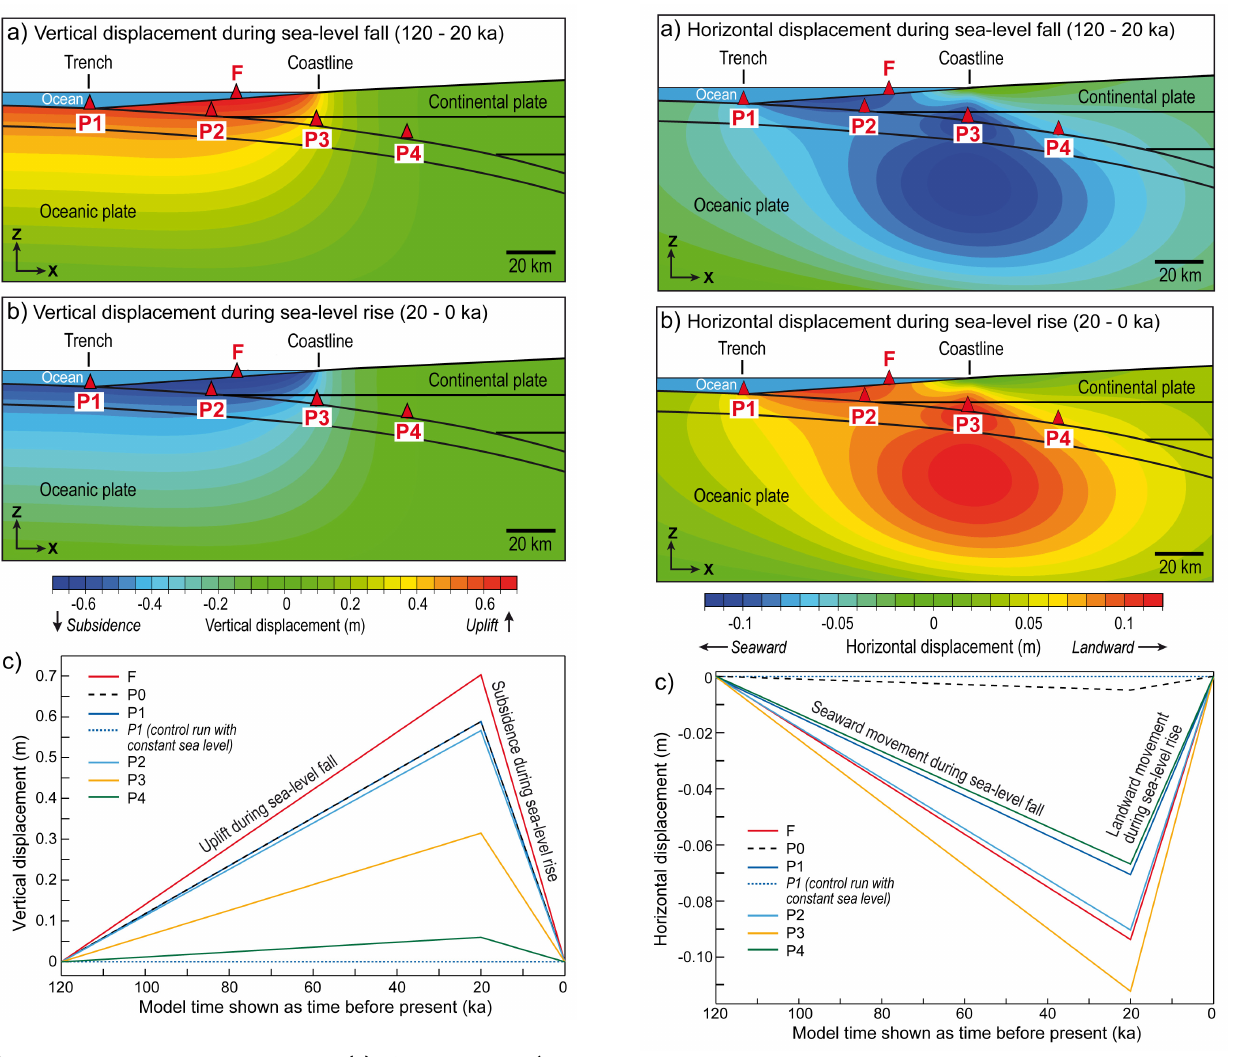
Fig. 3. Horizontal displacement induced by (a) a falling sea level (120–20ka) and (b) a rising sea level (20–0ka). (c) Temporal evo- lution of the horizontal displacements at point F in the forearc and at points P0–P4 located on the plate interface (Figs. 1a, 3a). For ref- erence, the result from the control run (constant sea level) is shown for point